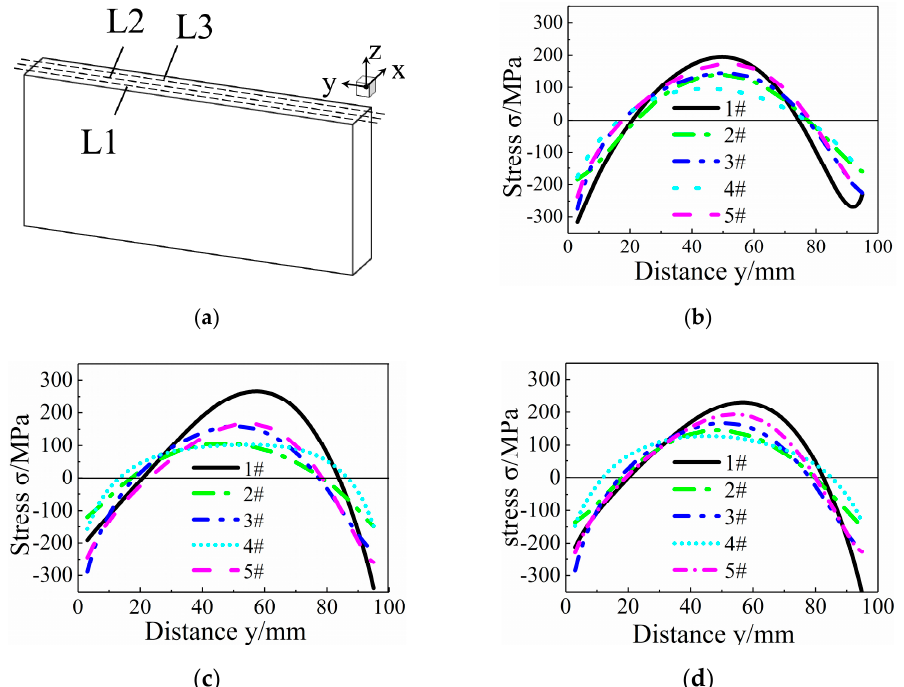
Figure 7. Comparison of stress along evaluation lines on cutting surface. ( a ) Schematic diagram of evaluation line. ( b ) Stress along line L1. ( c ) Stress along line L2. ( d ) Stress along line L3.